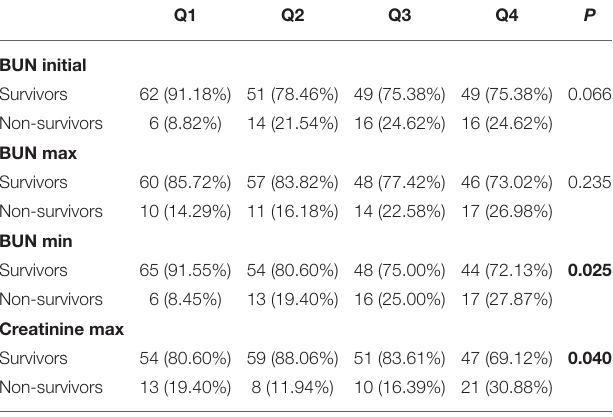
TABLE 4 | The relationship between BUN and creatinine with 90-day mortality.